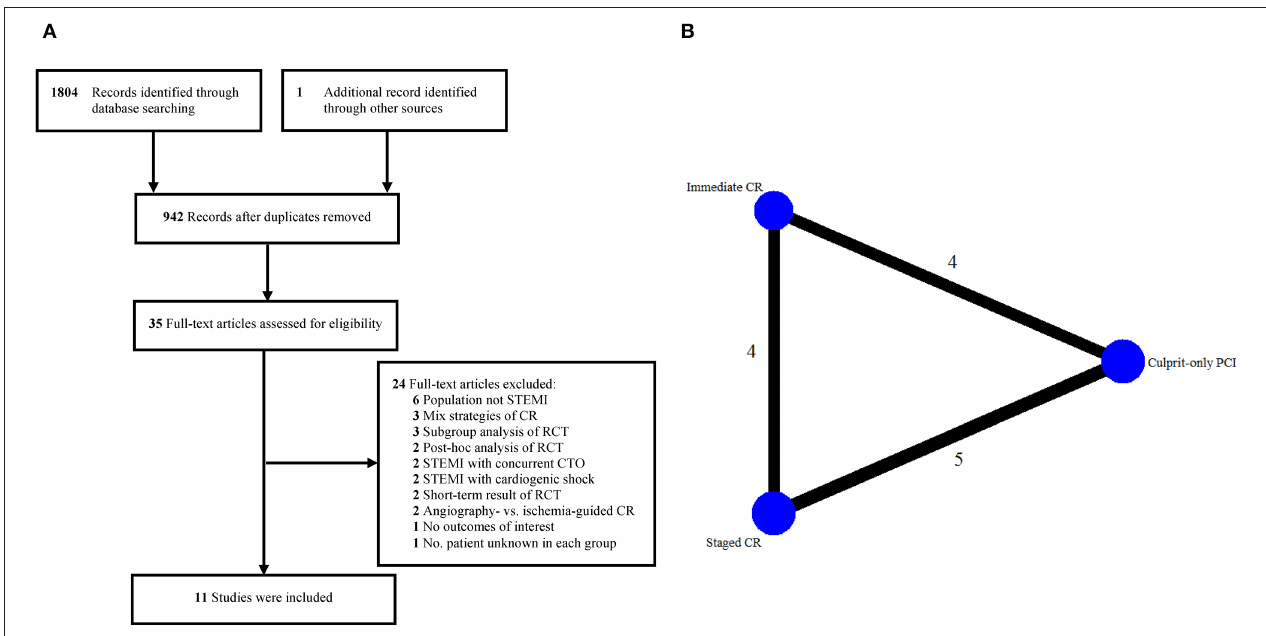
FIGURE 1 | Eligible studies. (A) Flow diagram of included studies. (B) Network diagram. CR, complete revascularization; CTO, chronic total occlusion; PCI, percutaneous coronary intervention; RCT, randomized controlled trial; STEMI, ST-segment elevation myocardial infarction.